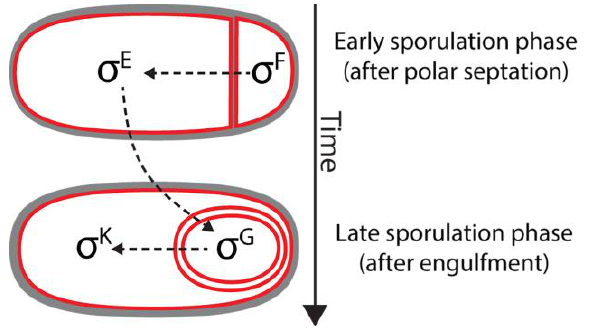
FIGURE 5: Cascade of sporulation-specific σ factors in B. subtilis . Immediately after polar septation, σ F is activated in the forespore. σ F activation triggers an intercompartmental signaling cascade that leads to the activation of σ E in the mother cell. Together σ F and σ E control gene expression during engulfment. Roughly coin- cident with the completion of engulfment, σ F is replaced by σ G in the forespore, which leads to the subsequent activation of σ K in the mother cell. σ G and σ K control gene expression in the forespore and the mother cell, respectively, after